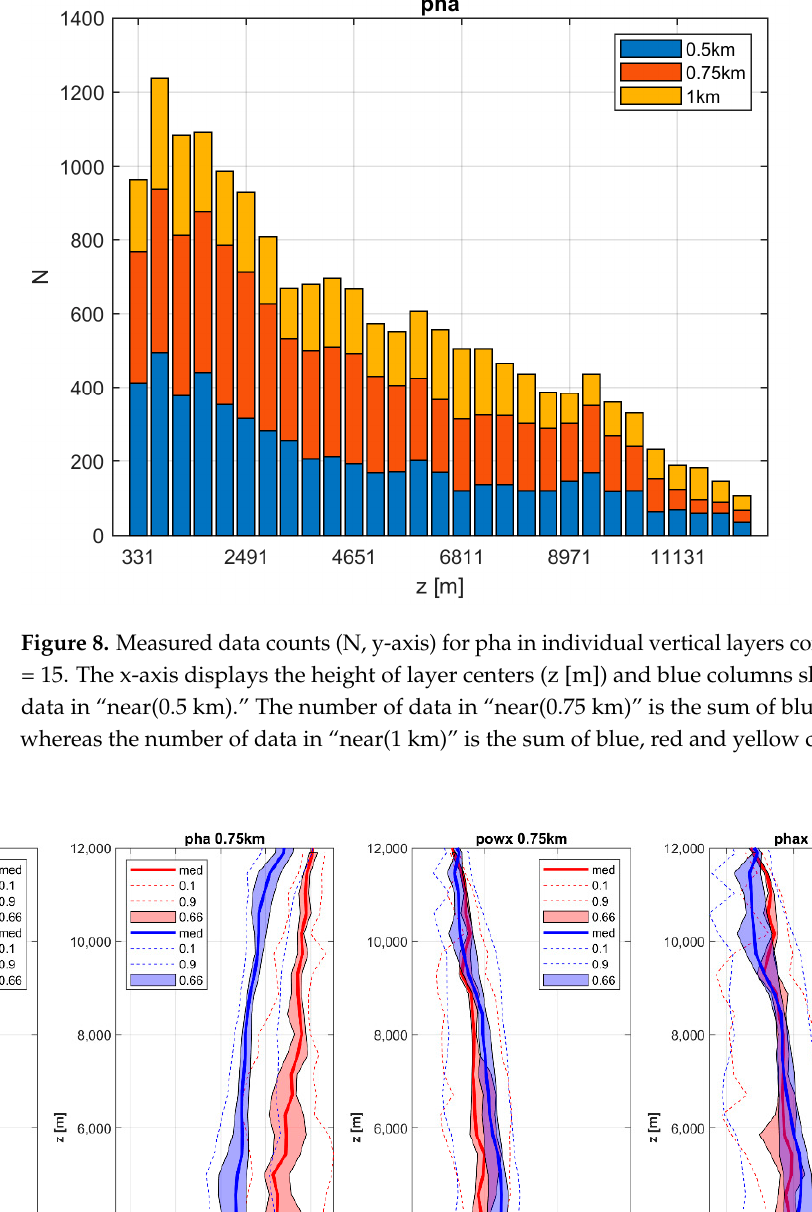
Figure 10. Comparison of statistical characteristics of pow, pha, powx and phax for “near(0.5 km)” and “far” data. Detailed figure caption is given in Figure 7. Both pha and phax are depicted using 10*log10(arctan) for better representation of vertical profiles of the data. 3.3. Correlation Analysis of Pow, Pha, Powx and Phax for “near” data vs. “far” Data To obtain the interrelationships between pow, pha, powx and phax, we performed a correlation analysis between pairs of the quantities. We calculated the correlation using the standard Pearson correlation coefficient (PC; [28]). Since the quantities have strongly asymmetrical distributions (Figure 5 and Figure 6) and there are nonlinear relationships between quantities, we also performed a control calculation using the Spearman correla- tion coefficient (SC; [28]). Resulting PC and SC correlations are presented in Figure 11 and Figure 12, respectively.